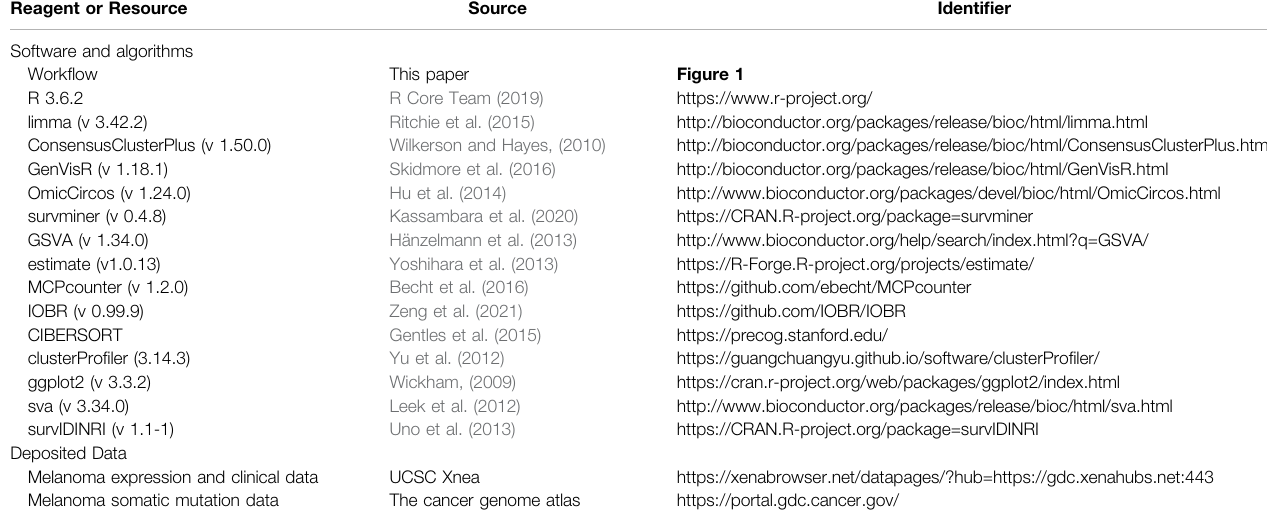
TABLE 2 | The detailed methods, software, algorithms and sources of each